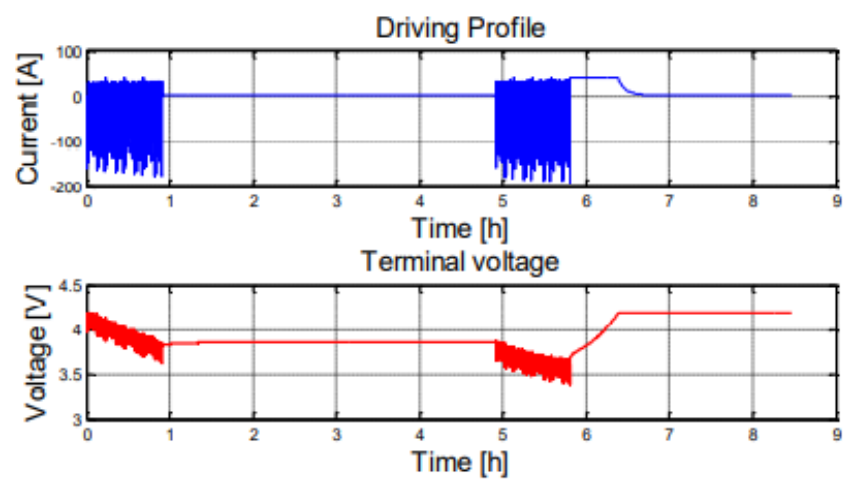
Figure 12. Current and voltage of real driving profile.